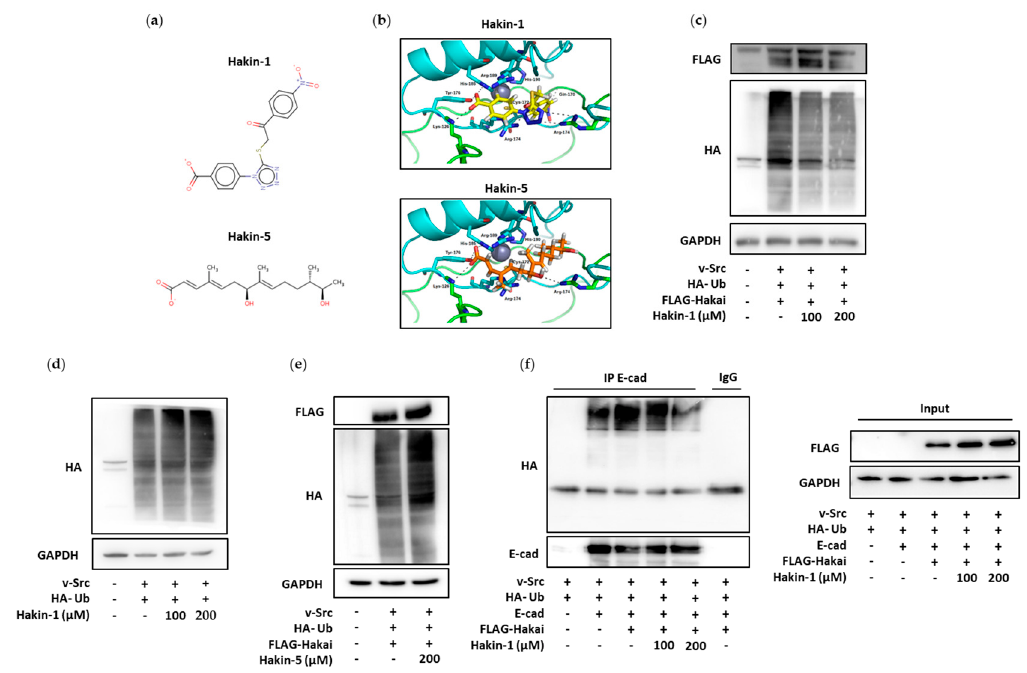
Figure 1. In silico and in vivo screening of E3 ubiquitin-ligase Hakai inhibitors ( a ) Chemical structure of Hakin-1 and Hakin-5. ( b ) Predicted binding poses for Hakin-1 (upper panel, in yellow) and Hakin-5 (bottom panel, in orange) molecules docked within Hakai dimers (represented in blue and green), as determined by the CRDOCK docking program. ( c ) Hakai-dependent ubiquitination assay in HEK293 cells transfected with Flag-Hakai, v-Src and HA-ubiquitin in the presence of either DMSO or compound Hakin-1. ( d ) Ubiquitination assay in HEK293T cells transfected with v-Src and HA-ubiquitin in presence of DMSO or compound Hakin-1. ( e ) Hakai-dependent ubiquitination assay in HEK293T cells transfected with Flag-Hakai, v-Src and HA-ubiquitin in the presence of either DMSO or compound Hakin-5. ( f ) E ff ects of Hakin-1 on Hakai-dependent ubiquitination of the E-cadherin complex. Flag-Hakai, myc-E-cadherin, v-Src and HA–ubiquitin were transiently transfected into HEK293 cells. Immunoprecipitation was performed with the anti-E-cadherin antibody before Western blotting using the indicated